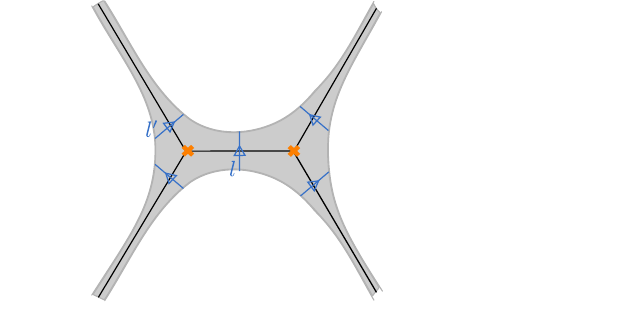
Figure 72 . Five ways in which the projection of L could cross C (cid:14) ; by an isotopy of L we can arrange that all crossings are of one of these (cid:12)ve